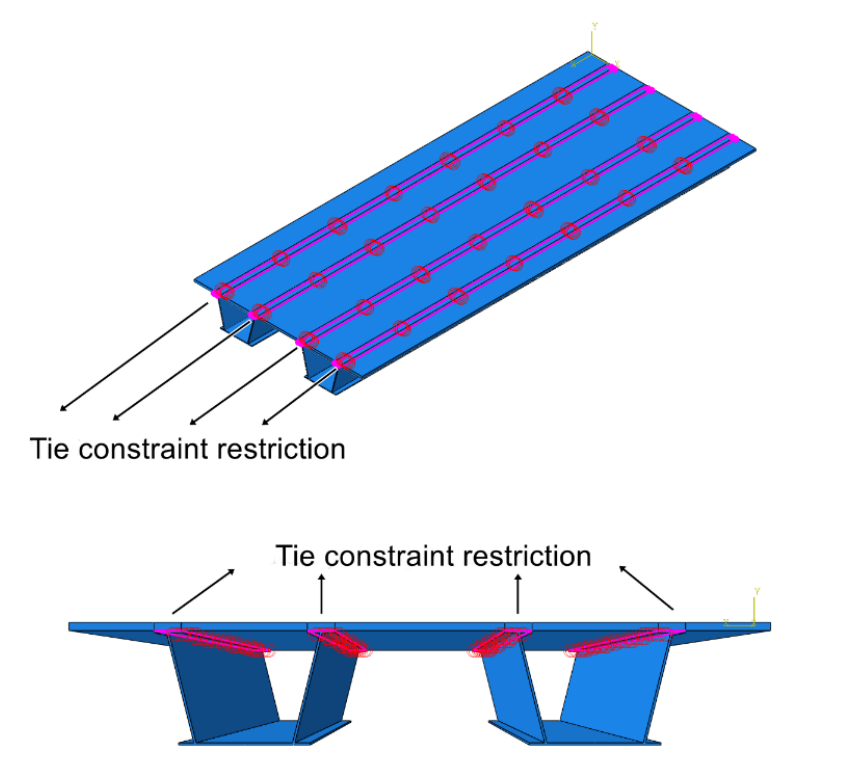
Figure 4. Relative interface displacement restricted by the Abaqus® [23] “tie constraint”